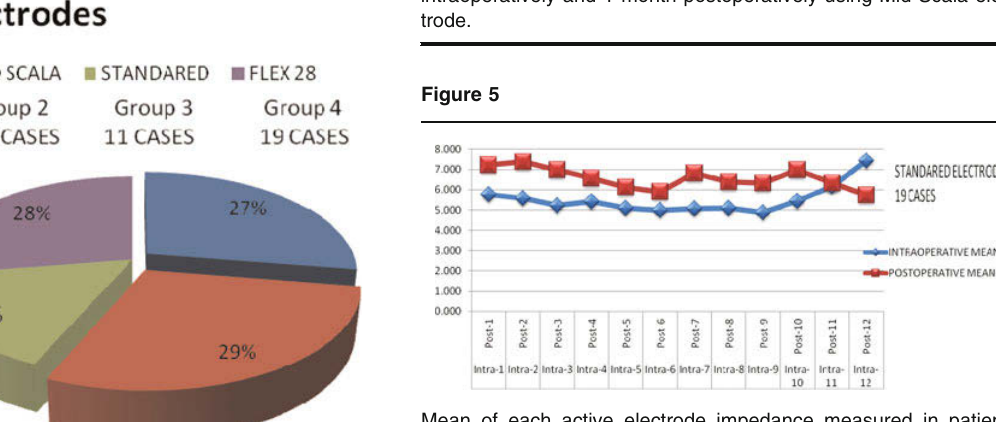
Mean of each active electrode impedance measured in patients intraoperatively and1 month postoperatively using standard elec-